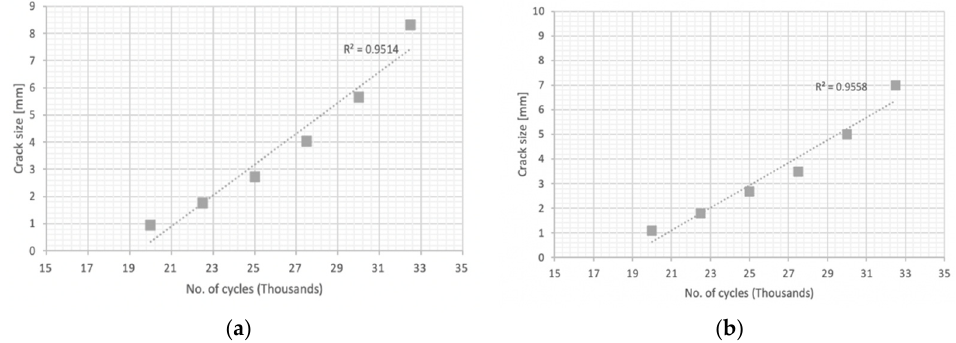
Figure 9. No. of cycles: crack size ( a ) Corbones Stringers; ( b ) Corbones Main Chords.